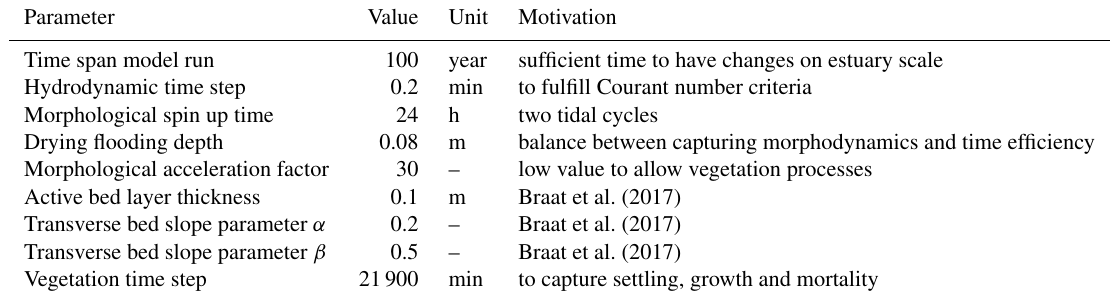
Table 1. The main hydromorphological parameter settings.